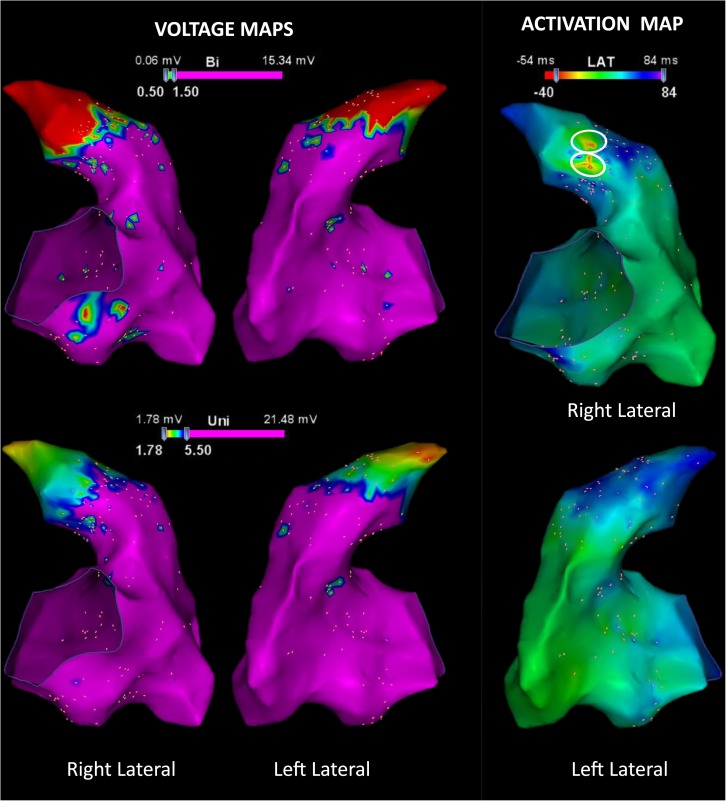
Representative example of the substrate maps during sinus rhythm.(A) Right and left lateral views of the endocardial bipolar and unipolar voltage maps demonstrate the areas of low voltage in the RVOT. (B) The activation map demonstrates the earliest activation site of the RVOT-VT (white circle).